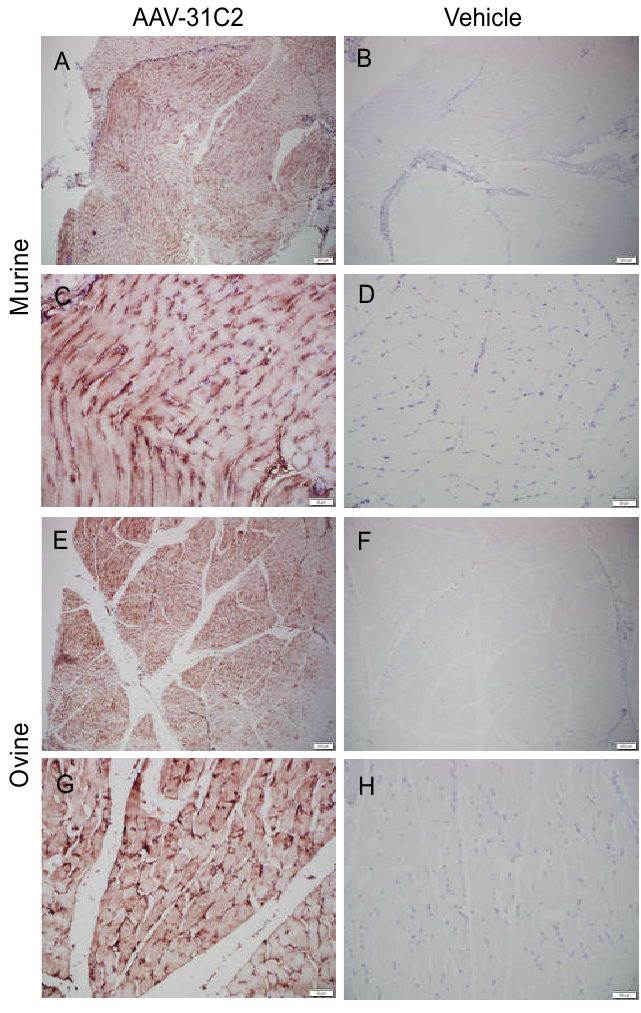
Figure 5. Immunohistochemical staining of human IgG in murine and ovine muscle. Stained murine muscle tissue from a mouse intramuscularly injected with 5 × 10 12 VG/kg AAV6.2FF-31C2 28 days prior at ( A ) 4 × and ( C ) 20 × and negative control murine muscle receiving vehicle only at (B) 4 × and ( D ) 20 × Stained ovine muscle tissue from sheep #8486 28 days post injection with 5 × 10 12 VG/kg AAV6.2FF-31C2 at ( E ) 4 × and ( G ) 20 × and healthy negative control tissue at ( F ) 4 × and ( H ) 20 ×.